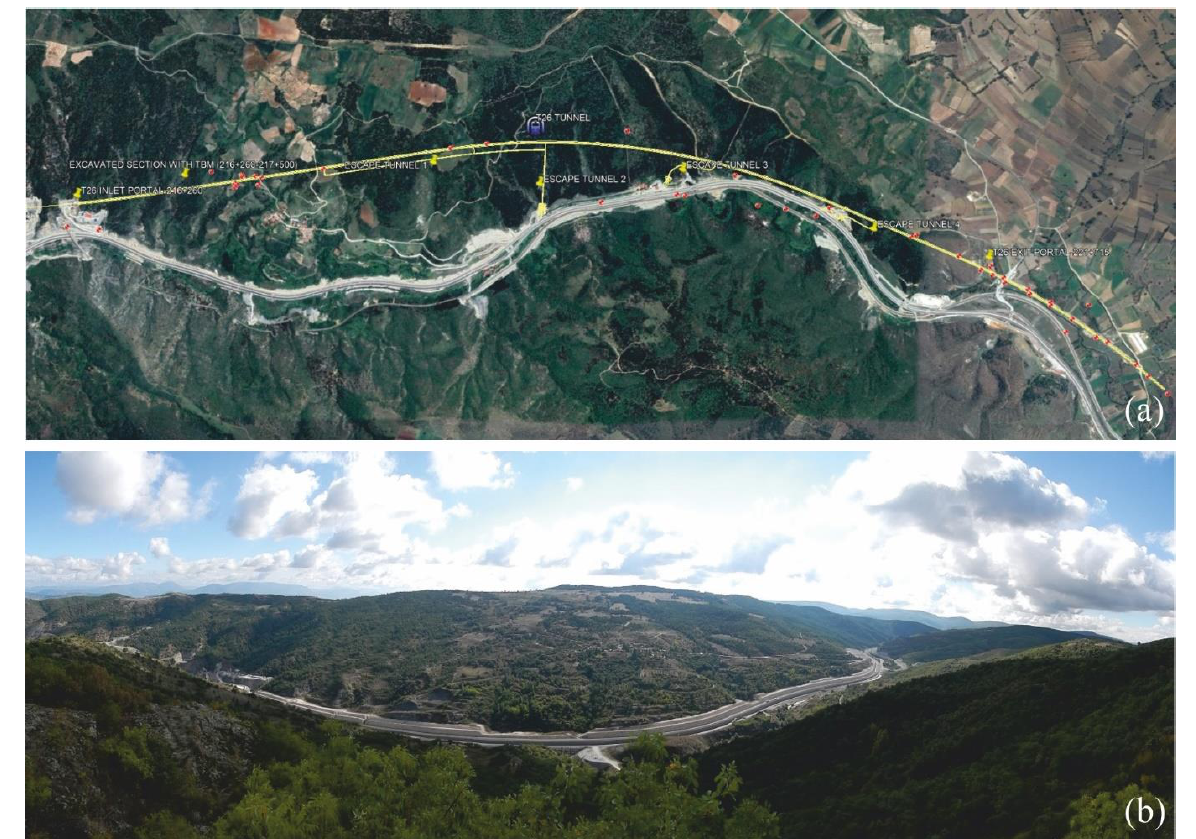
Figure 2. A view of the T26 tunnel route from Google Earth ( a ); a panoramic view from the site vicinity of the T26 tunnel ( b ).